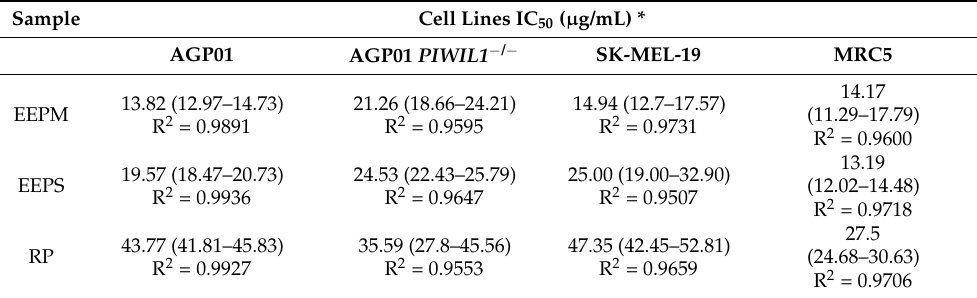
Table 3. Cytotoxic activity of macerated (EEPM), Soxhlet (EEPS), and retained (RP) extracts in cell lines after 72 h of